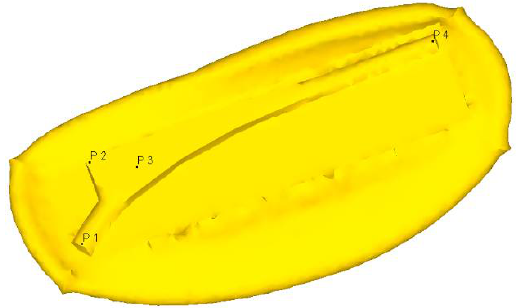
Figure 6. Four points (P1, P2, P3, and P4) are considered at different locations of the finished part of the hip joint for thermo-mechanical analysis.